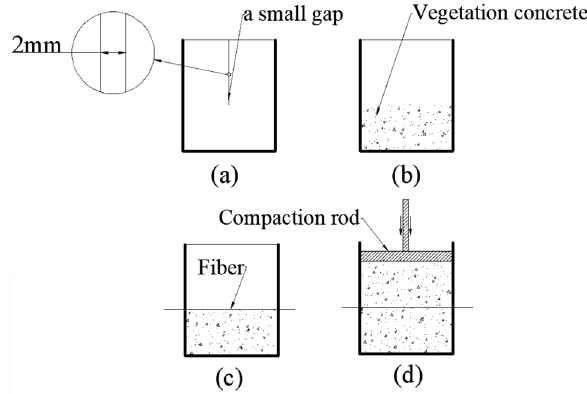
Figure 2. Sample preparing process (not to scale).